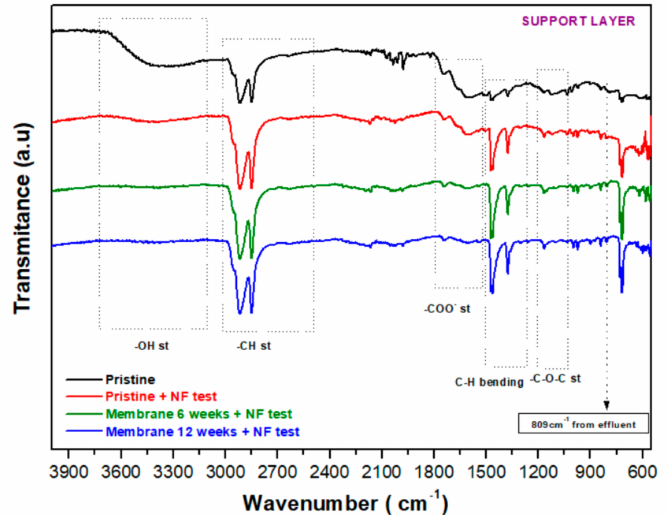
Figure 7. FT − IR spectra of the support layer in the pristine membrane before and after NF test, as well as aged FT − IR spectra of the support layers for membranes aged for 6 and 12 weeks used in NF